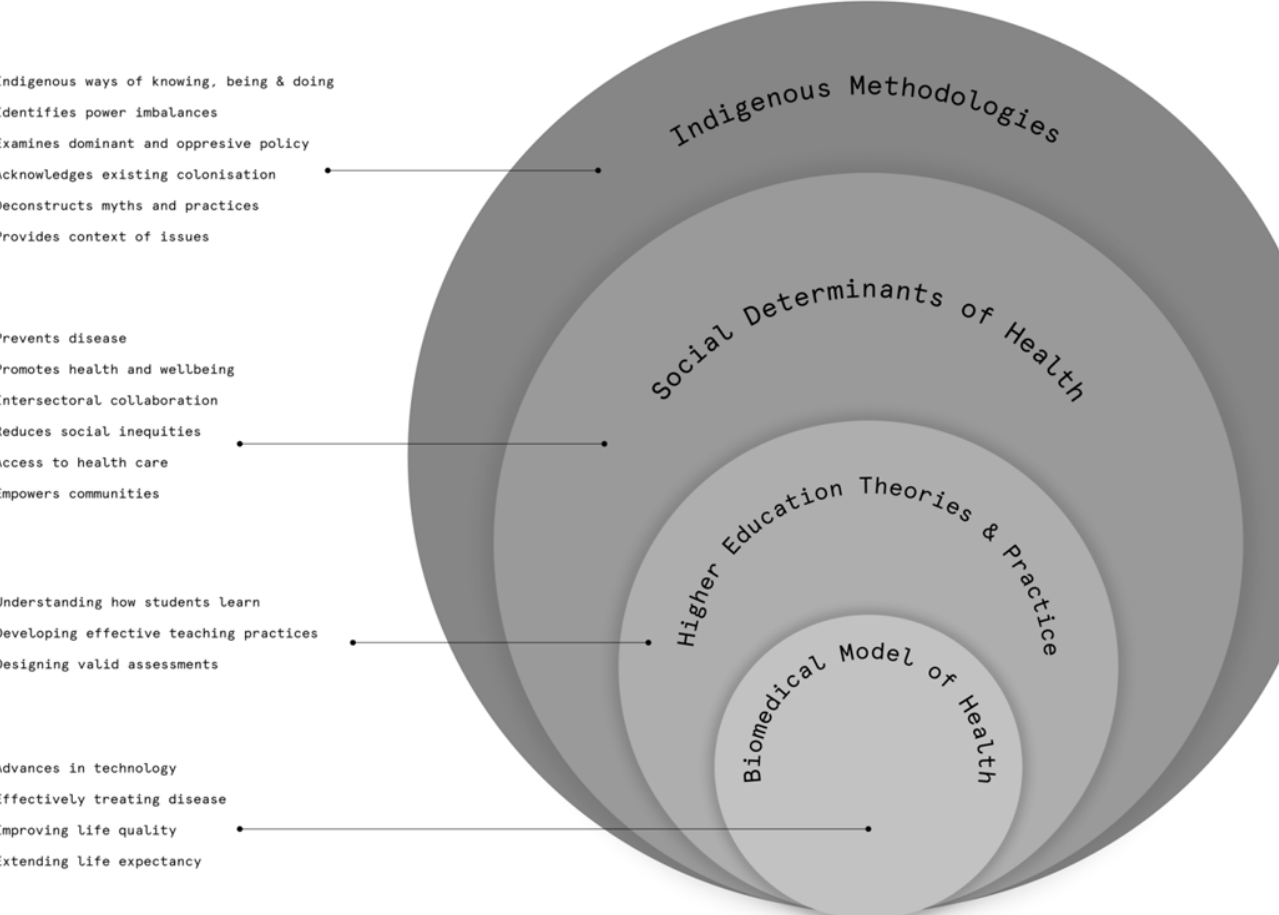
Figure 1: Conceptual framework for Indigenous cultural competence in dental and medical